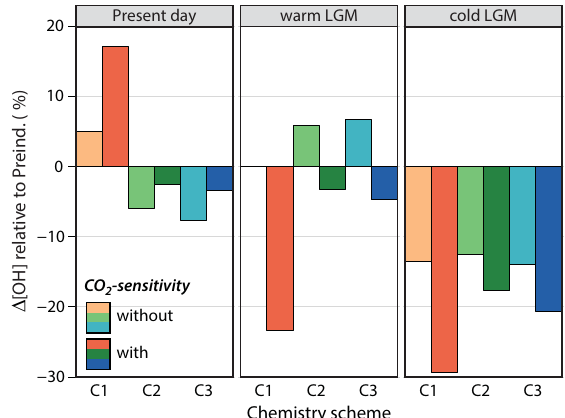
Figure 3. Percent changes (%) in the tropospheric mean mass- weighted OH burden for a range of scenarios relative to their respec- tive preindustrial scenarios (e.g., C1-w present day relative to C1-w preindustrial). Simulations are as described in Table 2. The climate scenarios are present day, preindustrial, warm LGM, and cold LGM. The chemistry schemes are C1 (orange bars), C2 (green), and C3 (blue). Plant isoprene emissions are modeled without (light shaded) or with (dark shaded) sensitivity to atmospheric CO 2 concentra- tions. For the present day, test simulations with and without CO 2 sensitivity yield nearly identical isoprene emissions. We therefore perform all present-day simulations with CO 2 sensitivity turned on and assume that these model results apply to the respective present- day “without” scenarios. (Note: The percent change at the warm LGM relative to the preindustrial is very small when the C1 chem- istry scheme is used without consideration of the CO 2 sensitivity (C1-wo), and so no light-orange bar is apparent in the middle